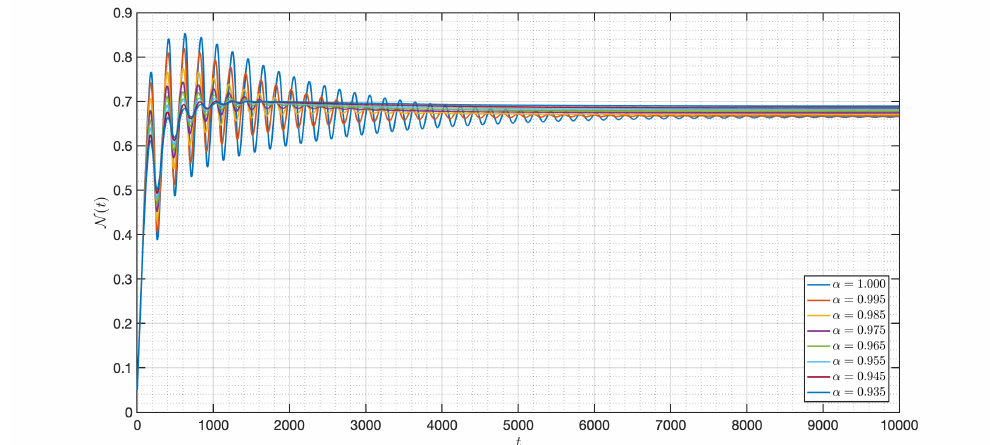
Figure 12. Dynamic of the model (3) for different parameters in Case II with α = 1.000.